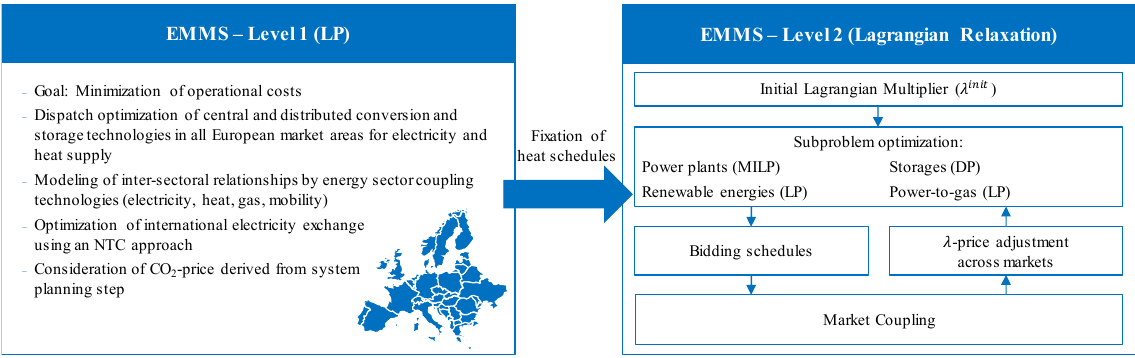
Figure 1. Overview of the European multimodal market simulation (EMMS) model [31].